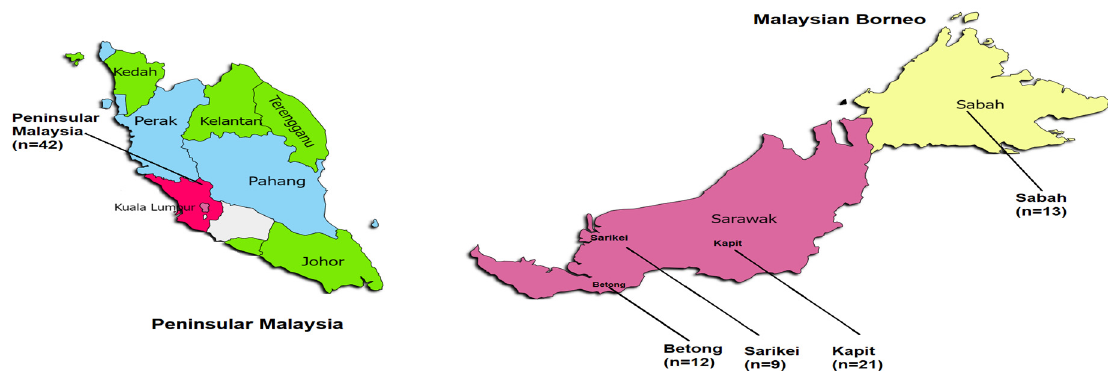
Figure 1. Sample origin from various locations of Malaysia. The n represents the number of sequences from each location.